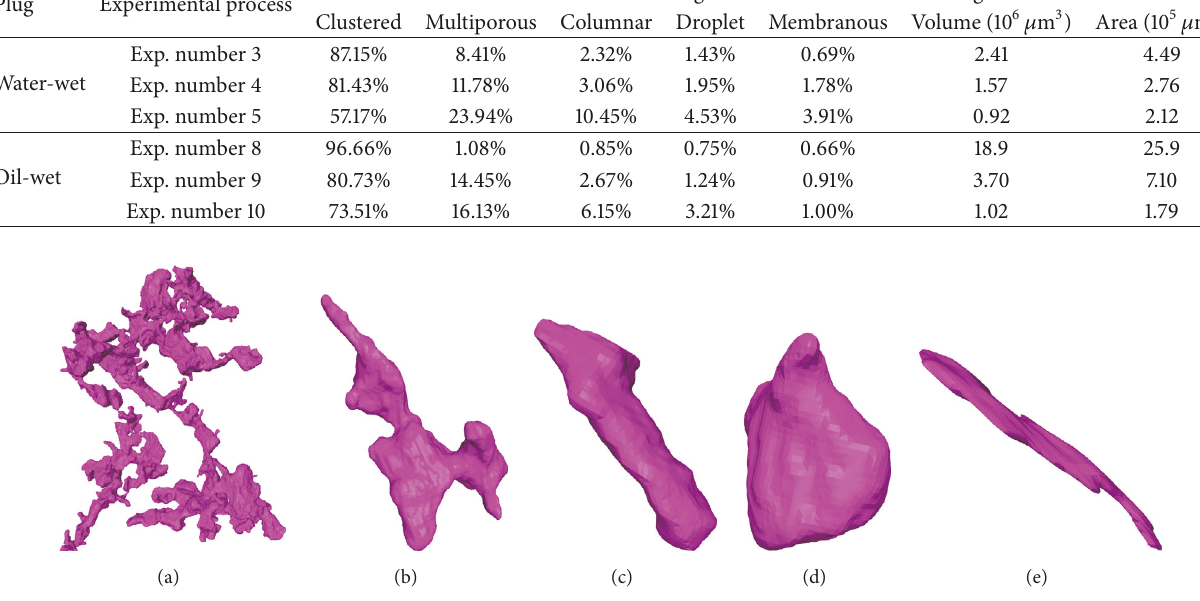
Figure 9: Morphologies and volumes of the five types of oil clusters after 1-PV water drainage in oil-wet plug: (a) clustered (volume = 6.07 × 10 6 𝜇 m 3 ); (b) multiporous (volume = 3.89 × 10 5 𝜇 m 3 ); (c) columnar (volume = 9.3 × 10 4 𝜇 m 3 ); (d) droplet (volume = 3.08 × 10 3 𝜇 m 3 ); (e) membranous (volume = 2.17 × 10 3 𝜇 m 3